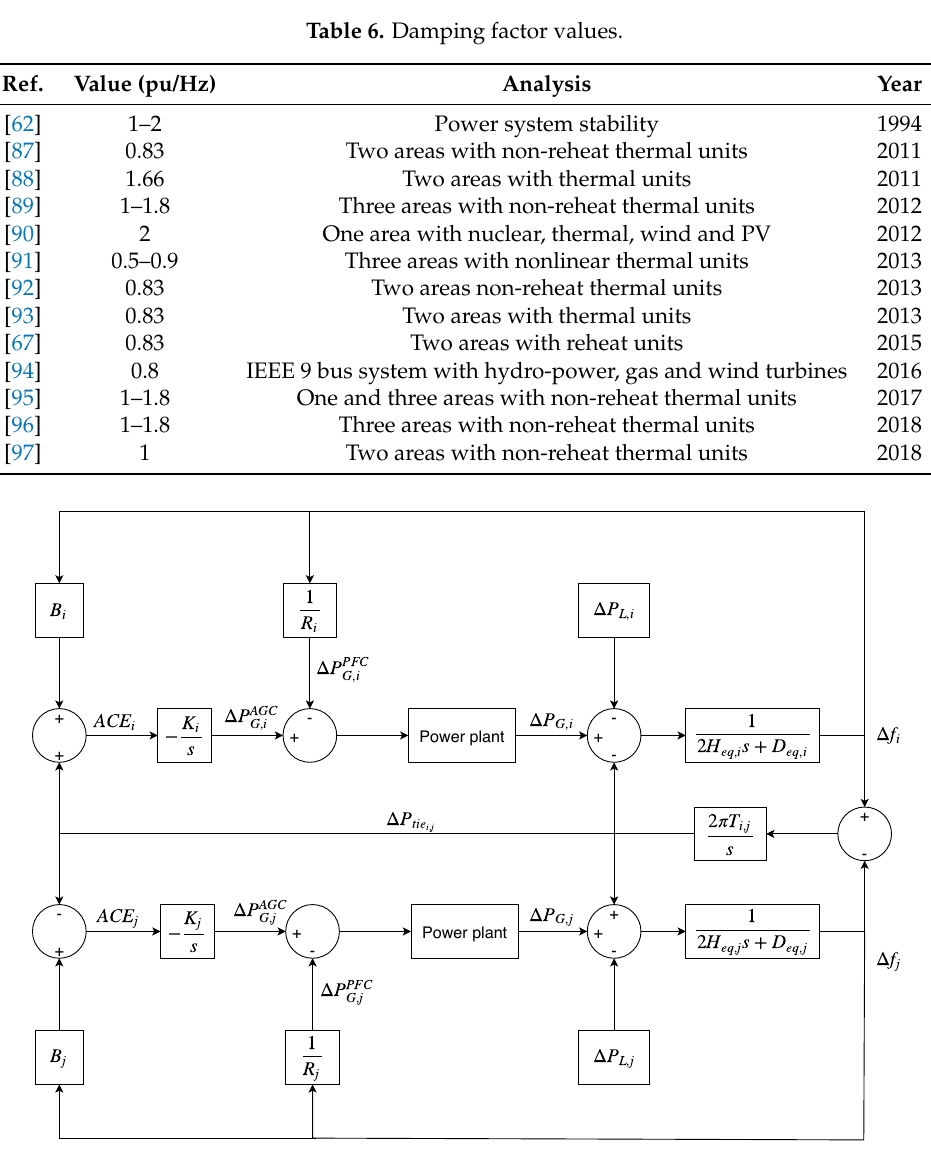
Figure 7. Two-area power system modeling for frequency